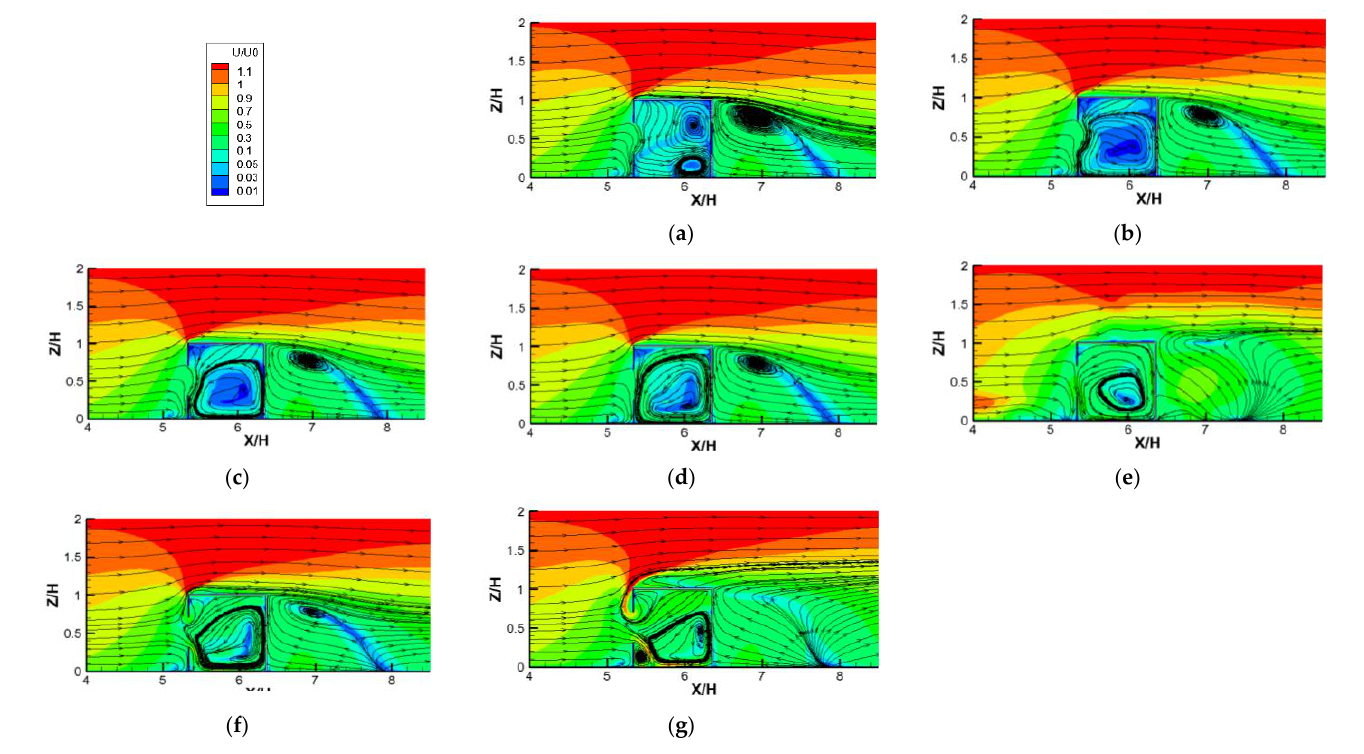
Figure 9. Contours of dimensionless velocity ( U / U 0 ) against increasing Ri numbers for single-sided ventilation cases. ( a ) Ri = 0; ( b ) Ri = 0.04; ( c ) Ri = 0.27; ( d ) Ri = 1.86; ( e ) Ri = 5.31; ( f ) Ri = 11.11; ( g ) Ri =